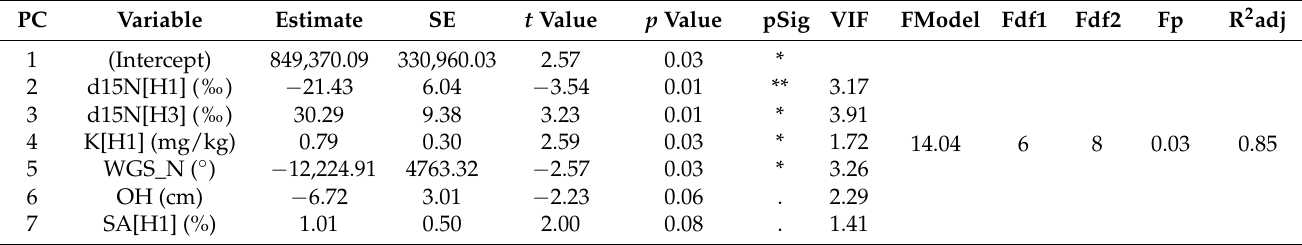
Table 5. Overview of variables included in the optimal multiple regression model (Biomass = f(Variable1, . . . , Variable7)) derived for Lama and their statistical characteristics (H1—soil layer 0–10 cm, H2—layer 10–20 cm, H3—layer 20–30 cm, d15N (‰)—ratio of stable nitrogen isotopes 15N:14N, K (mg/kg)—potassium content, WGS_N ( ◦ )—latitude, OH (cm)—thickness of O horizon—surface organic layer, SA (%)—sand fraction, Estimate = regression coefficient for the respective variable, SE= standard error, t value— t -value of Student test of coefficient, p value—probability of t value and its significance of p